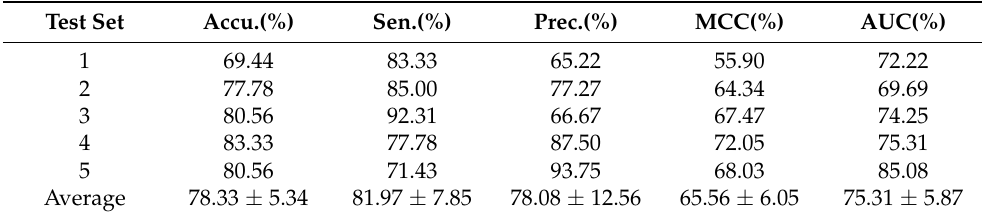
Table 4. 5FCV prediction results obtained by RoFDT on the Nuclear Receptor dataset.